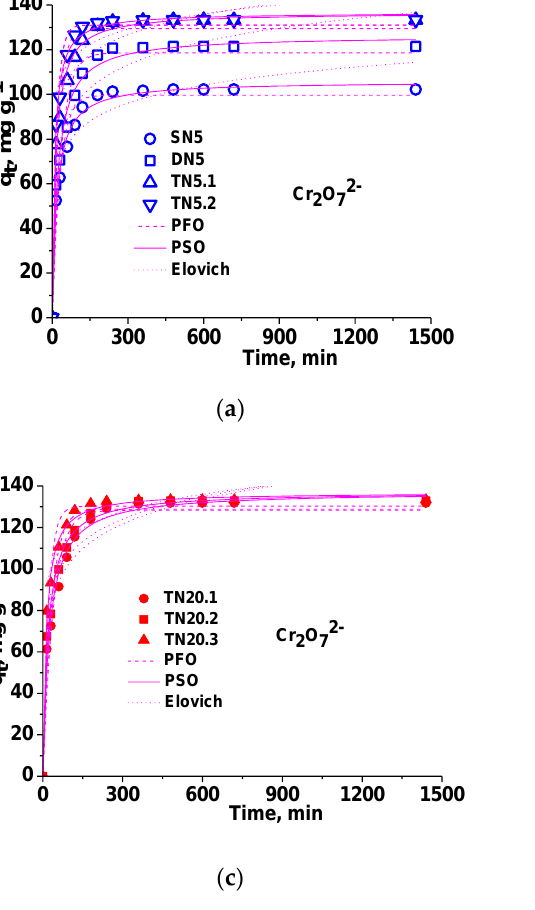
Figure 5. Comparative sorption kinetics of Cr 2 O 72 − anions onto SN, DN and TN composite sorbents ( a – c ). Sorption kinetics of H 2 PO 4 − onto DN and TN composite sorbents ( d ); sorbent dose = 7.5 mg, Vsol = 10 mL, pH = 3 for SN and DN, and pH = 4 for TN; temp = 23 °C; C in = 100 mg/L.